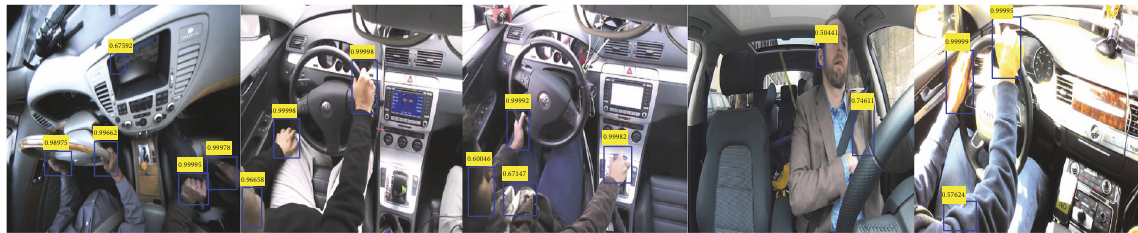
Figure 15: Incorrect examples on the VIVA